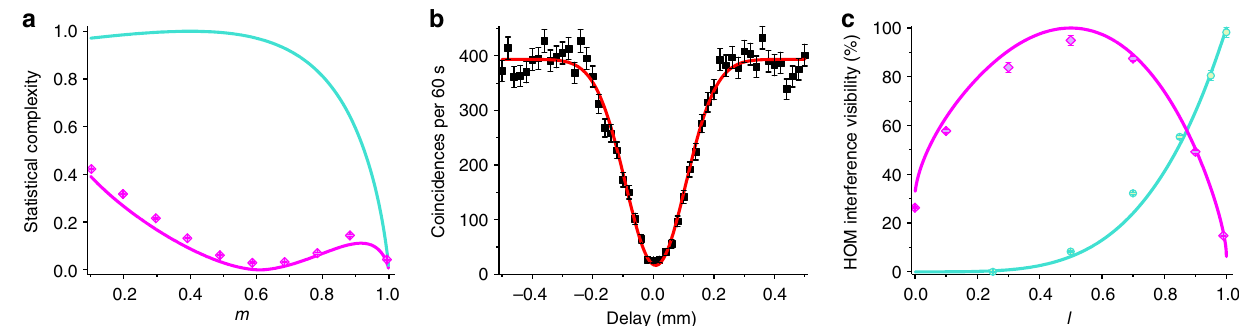
Fig. 5 Experimentally determined complexity and interference visibility. a The quantum statistical complexity C q of our quantum simulator, as the probability of remaining in tails during perturbation, m , is varied. The probability of remaining in heads, l , is fi xed at 0.4. Due to small experimental imperfections the actual implemented values of l and m deviate slightly from the nominal round values (see Methods for more details). Data points are experimental measurements of C q , and the magenta and turquoise curves are theoretical estimations for the quantum and classical complexities C q and C μ , respectively. b Two-photon interference of the superpositions of future trajectories in two implemented stochastic processes, Π 1 and Π 2 , with Π 1 = Π 2 such that l = 0.5 and m = 0.5 and thus | S 0 〉 = | S 1 〉 . Since Π 1 = Π 2 , an interference visibility of 100% is theoretically expected, while fi tting the experimental data yields a visibility of 0.96 ± 0.02. In the graph, the number of measured twofold coincidences is depicted versus the relative delay between single-photon wave packets. c Magenta and turquoise elements (points — experiment; curves — theory) show the comparison of the statistical futures from two stochastic processes by two-photon interference visibility. In each case, one process ( Π 1 ) is fi xed, and the other process ( Π 2 ) has fi xed m but varying l . Magenta represents interference of the output states of the simulators for Π 1 (| S 0 〉 is the input memory state, l = 0.5, and m = 0.5) with Π 2 (| S 0 〉 is the input memory state, m = 0.5, and l varying). Turquoise represents interference of the output states of the simulators for Π 1 (| S 0 〉 is the input memory state, l = 1.0, and m = 1.0) with Π 2 (| S 0 〉 is the input memory state, m = 0.5, and l varying). Uncertainties, from the Poissonian distribution of photon counts, are so small that they are barely visible in some of the